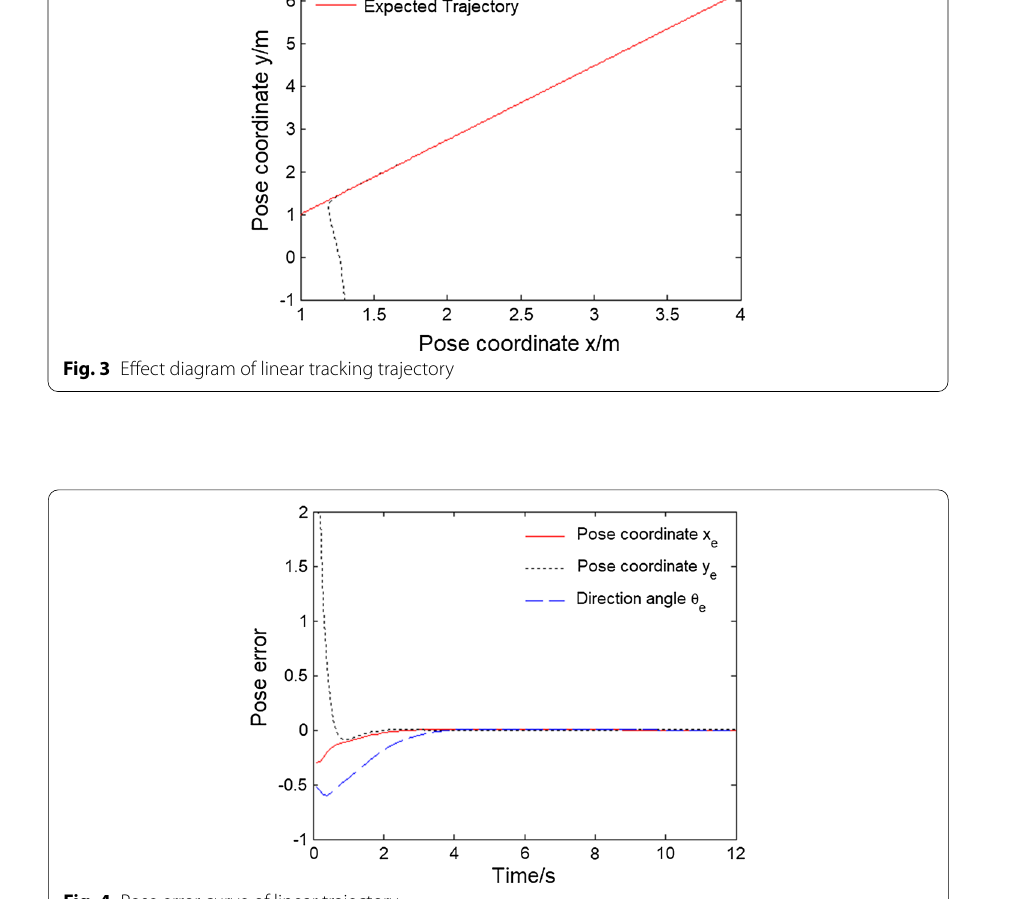
Fig. 4 Pose error curve of linear